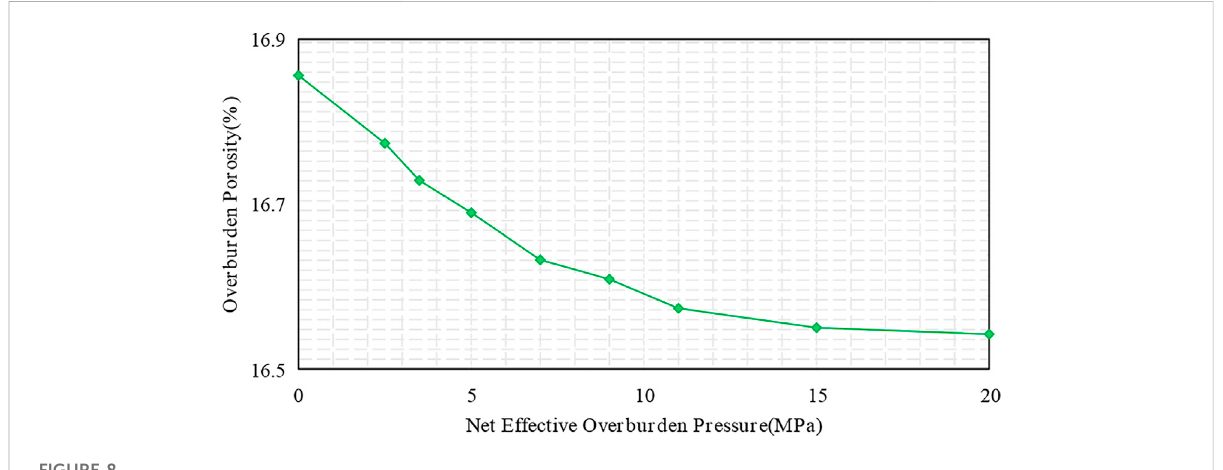
Relationship between overburden porosity and